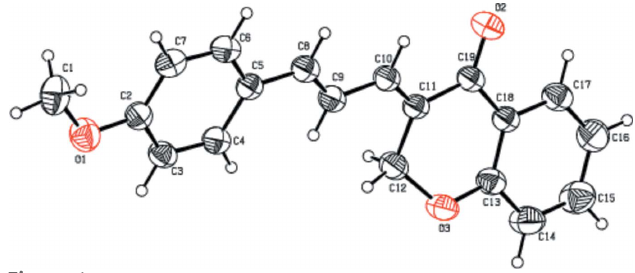
The molecular structure of the title compound, with displacement ellipsoids drawn at the 30% probability level.